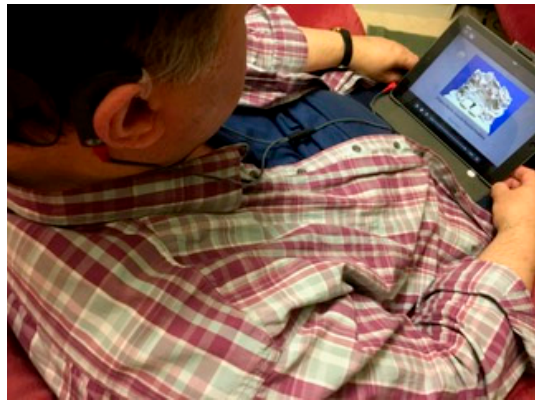
Figure 4. Example of listening to a sound description, through CI and T- Loop: Photographer: Riitta Lahtinen.